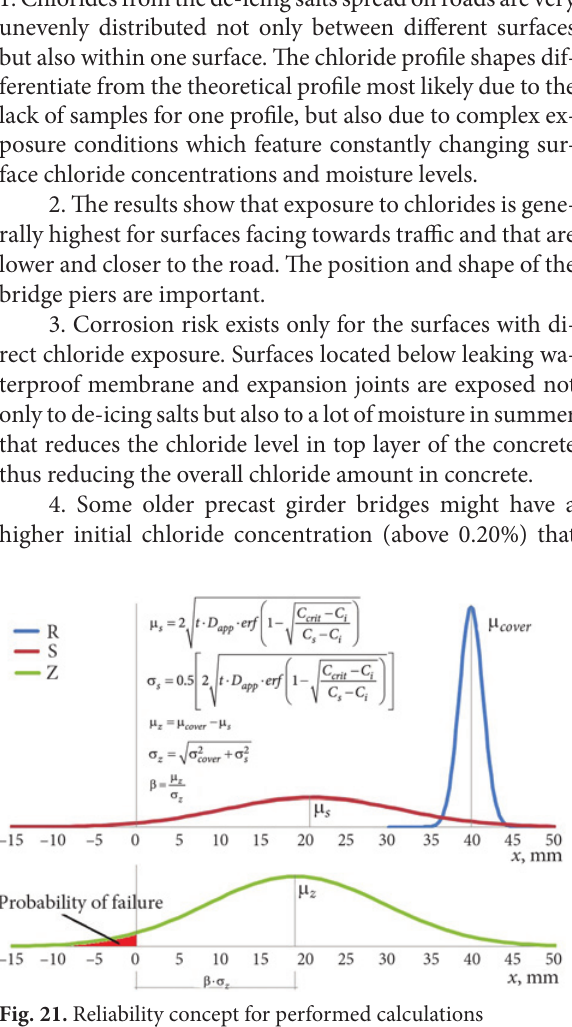
table 3. Service life calculation parameters and results